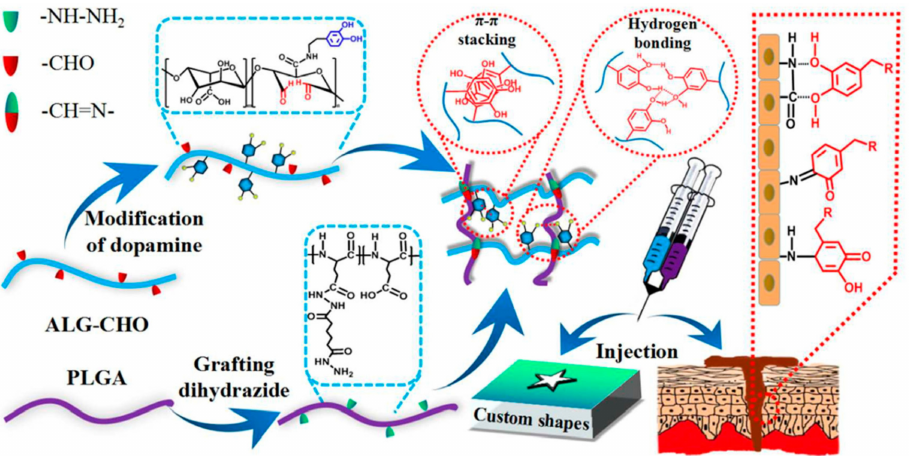
Figure 7. Schematic illustration of the mussel-inspired PLGA / ALG-CHO-catechol adhesive injectable hydrogels. The combination of aldehyde-modified alginate backbones (ALG-CHO)-catechol and polyglutamic acid with hydrazide (PLGA-ADH) led to self-cross-linking of a three-dimensional (3D) network in the form of hydrogels, allowing custom shapes to be completely matched and filled. The hydrogels with abundant free catechol groups were inspired by marine mussels, forming various interactions like π - π stacking and hydrogen bonds in the 3D network, and adhering to di ff erent surfaces even in wet environments. Reproduced with permission from Ref. [72], Copyright 2018, Royal Society of